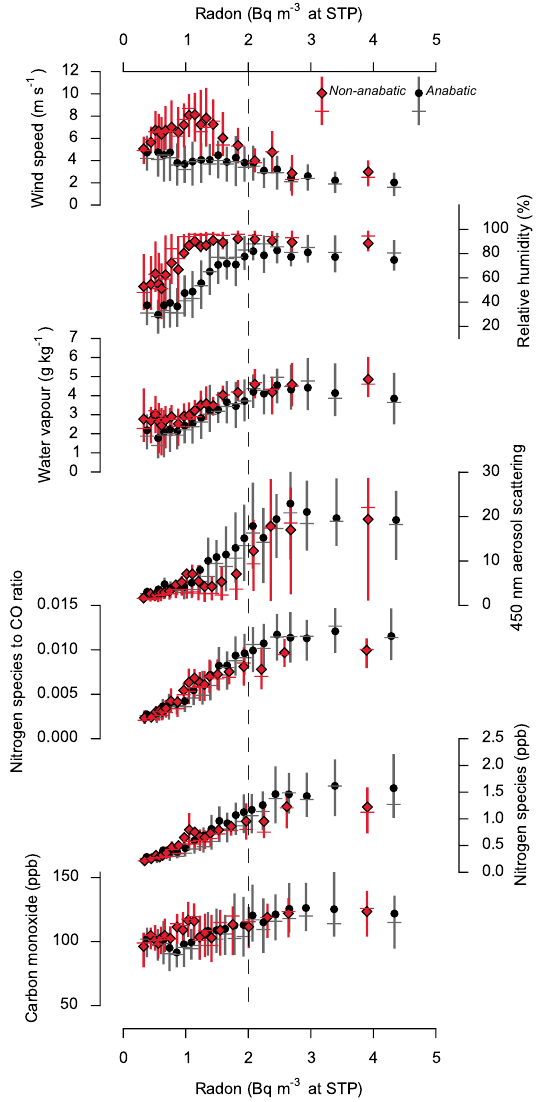
Figure 10. Hourly observations of tracer and meteorological pa- rameters binned according to radon concentration for anabatic and non-anabatic days. The comparison is restricted to the months when anabatic flows are detected (April–September); hours when the air mass arrives from the north-west; and when the radon and moisture methods agree on the anabatic/non-anabatic classification. For mod- erate radon concentration, anabatic days are calmer and dryer and aerosols are more abundant. The symbols have the same meaning as in Fig.